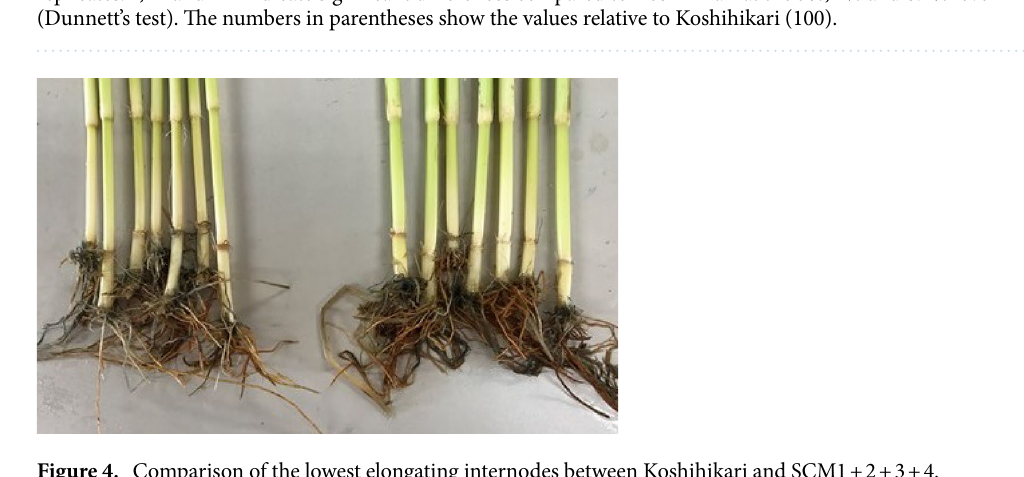
Figure 4. Comparison of the lowest elongating internodes between Koshihikari and SCM1 + 2 + 3 + 4. Representative photographs of the lowest elongating internodes in Koshihikari (left) and SCM1 + 2 + 3 + 4